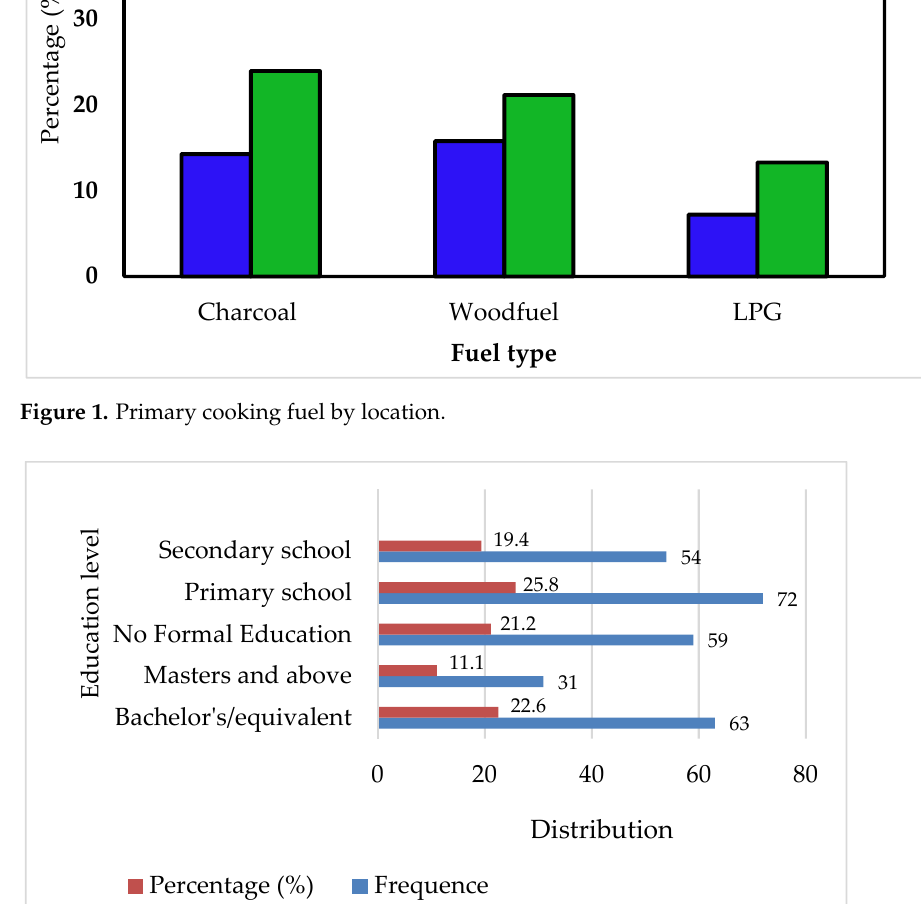
Table 3. Households' clean cooking (LPG in our case) awareness among participants.